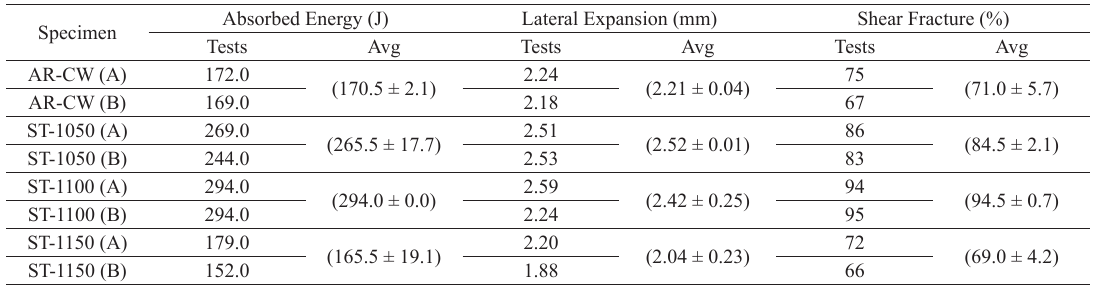
Table 7. Charpy V-notched Impact test at – 46 ºC results.